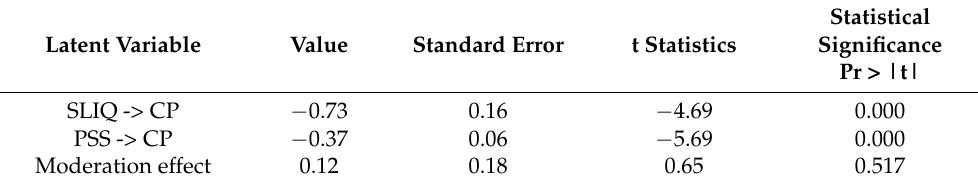
Table 6. Findings from the moderation analysis between stress, concentration performance, and lifestyle among participants during the confinement.